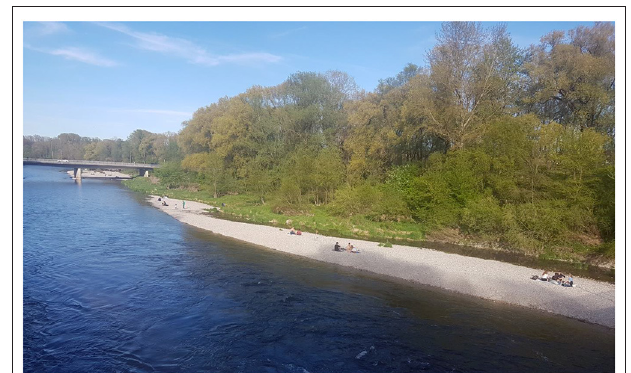
FIGURE 3 | Public uses of the Isar River (May 2021, credit: Aude Zingraff-Hamed).